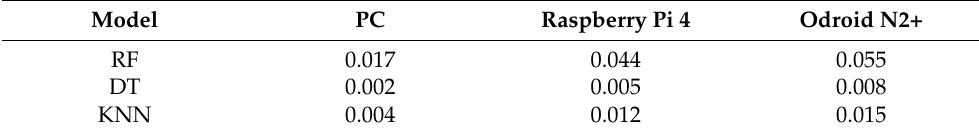
Table 6. Average time (sec) to obtain a posture varying classifiers and platforms.